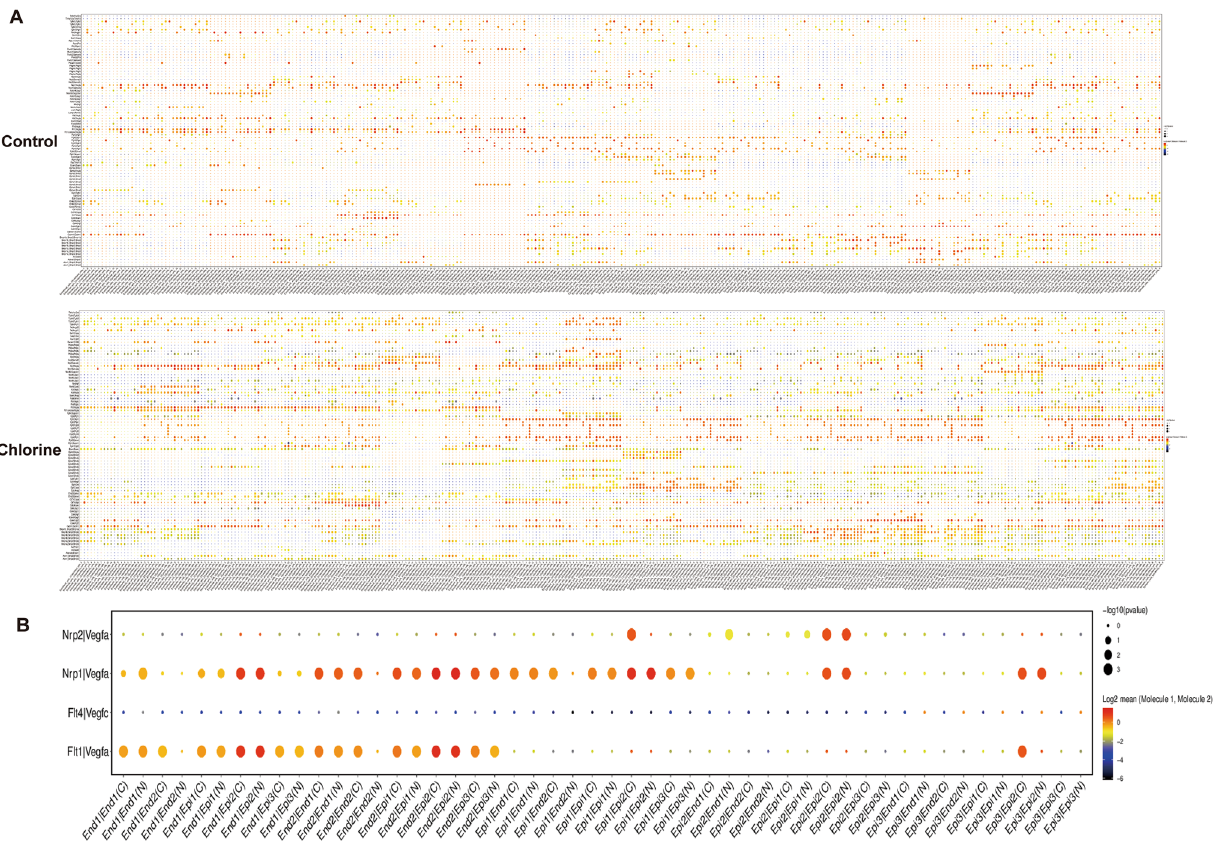
Figure 6. Intercellular epithelial–endothelial cells communication regulation based on ligand–receptor analysis. ( A ) Overview of selected ligand receptor interactions of epithelial and endothelial cells. ( B ) Nrp1-Vegfa, Nrp2- Vegfa, Flt1-Vegfa and Flt4-Vegfa of selected ligand receptor interactions of epithelial and endothelial cells. N control group, C Cl 2